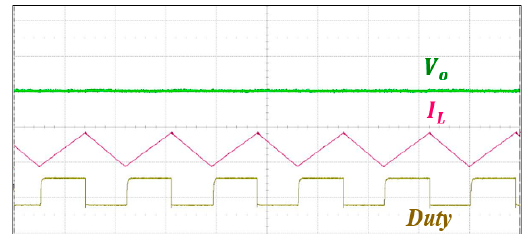
Figure 27. Inductor current waveform before a rise in output voltage. (10 V/div, 1A/div, 25 us/div).